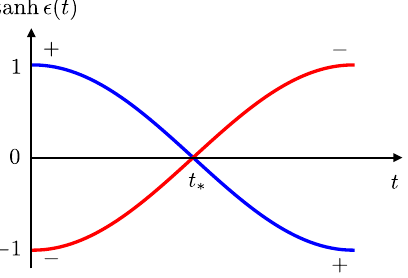
FIG. 4. Symmetry-charge pumping in micromotion of entan- glement spectrum . — The quasienergy spectrum (reparametrized by tanh to fall between (cid:3) 1 rather than (cid:3) ∞ ) of the Z 2 -symmetry protected bosonic FSPT exhibits a quantized pumping of Z 2 symmetry charge, in each Floquet